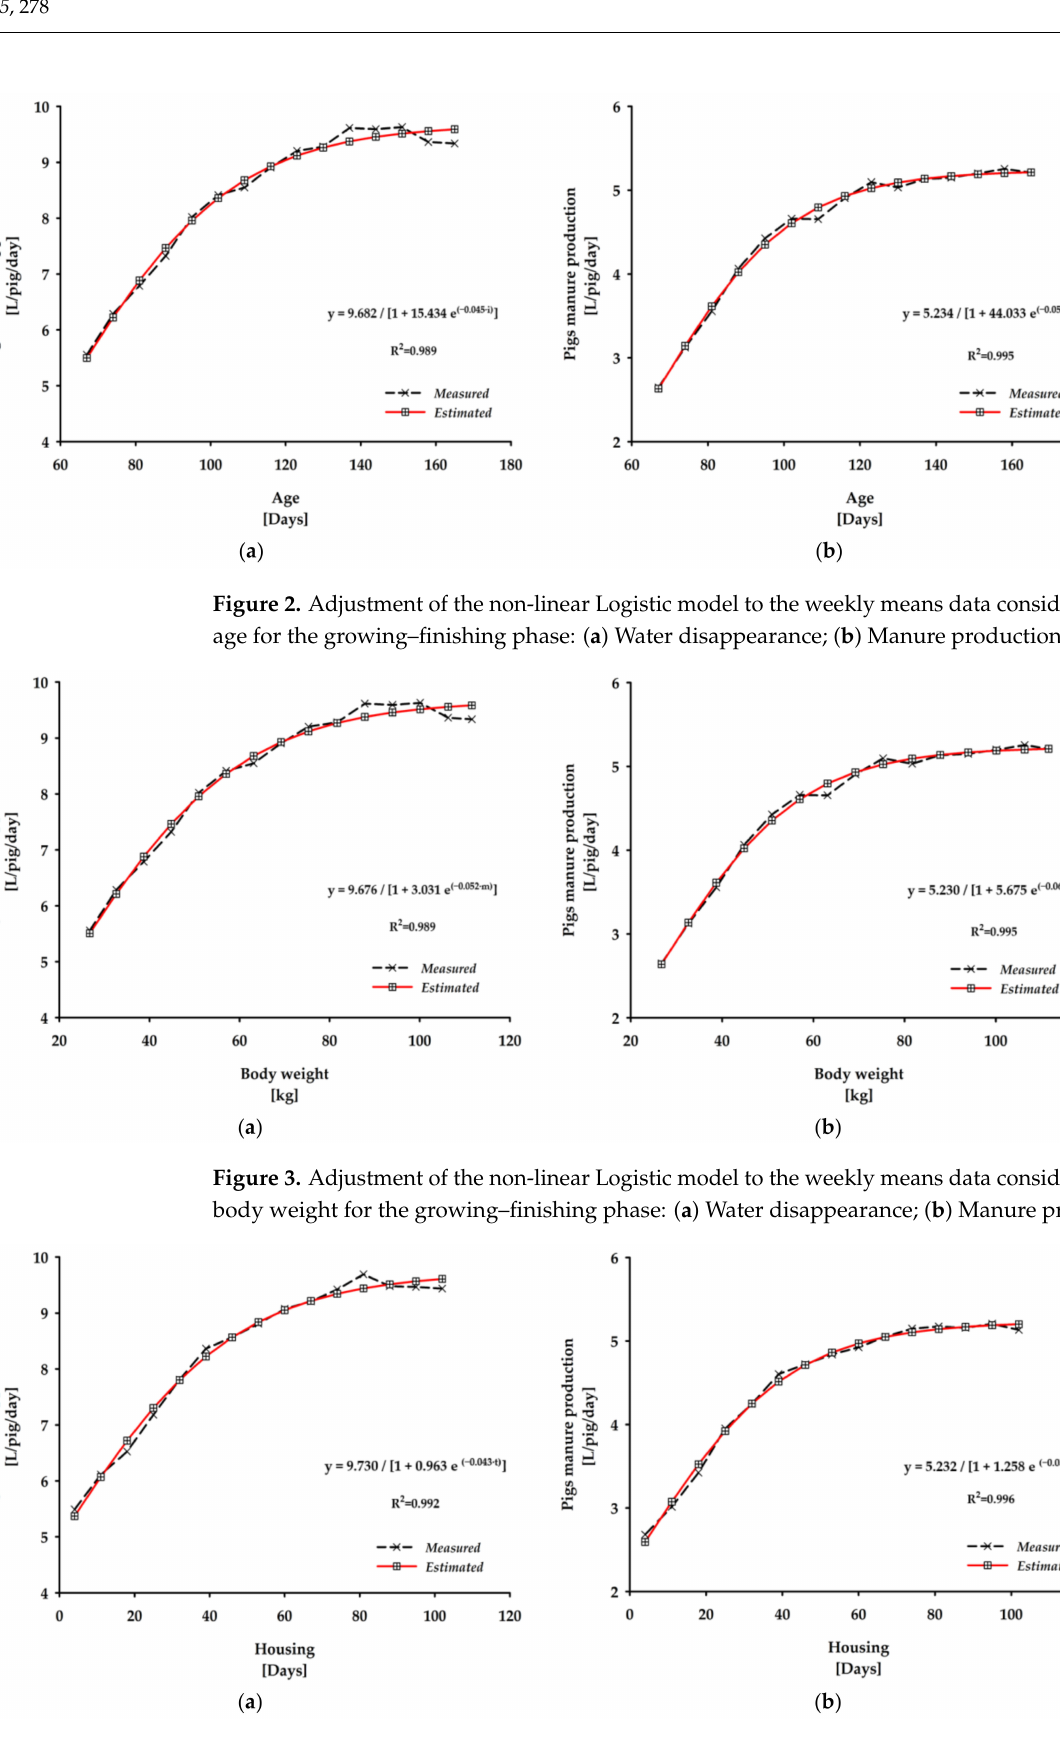
Figure 4. Adjustment of the non-linear Logistic model to the weekly means data considering the pigs’ housing period for the growing–finishing phase: ( a ) Water disappearance; ( b ) Manure